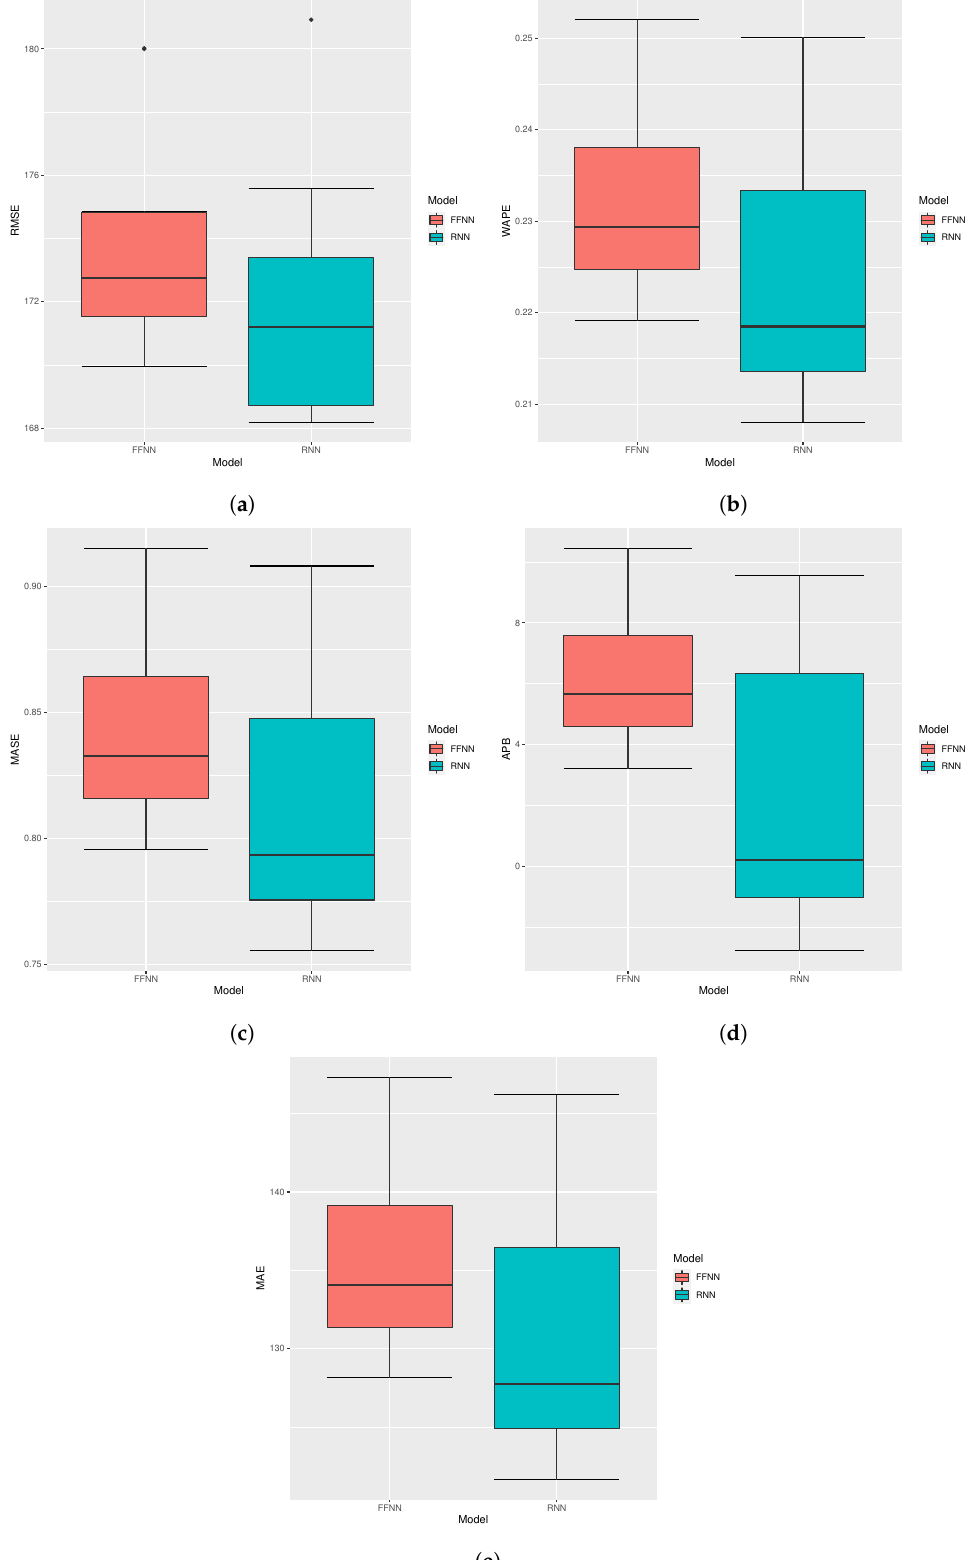
Figure 15. Evaluation of metrics for deep learning models. ( a ) RMSE for FFNN and RNN. ( b ) WAPE for FFNN and RNN. ( c ) MASE for FFNN and RNN. ( d ) APB for FFNN and RNN. ( e ) MAE for FFNN and